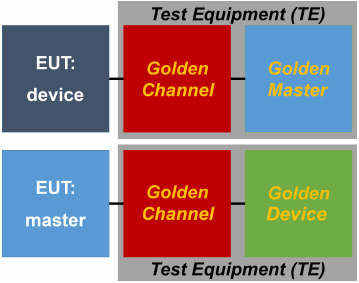
Figure 9. Block diagram of the basic test